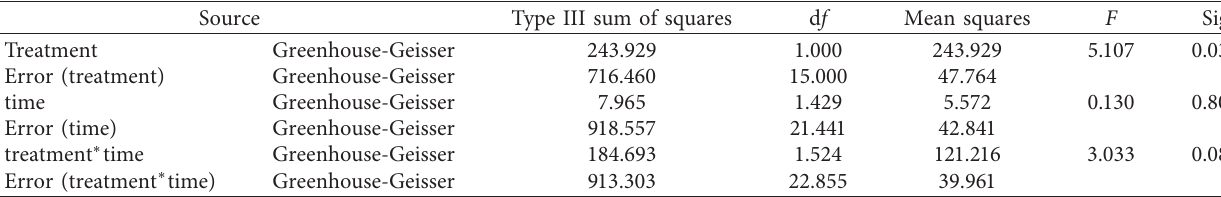
Figure 1: Line chart of the changes in mean albumin over time. Table 3: Tests of within-subject effects.